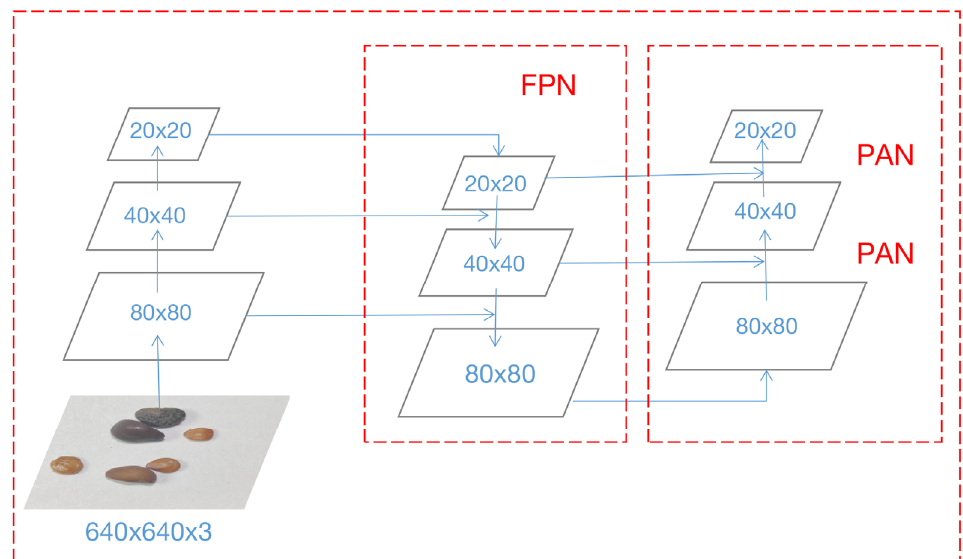
Figure 6. FPN+PAN